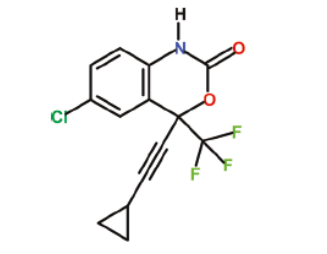
Figure 1. Chemical structure of Efavirenz